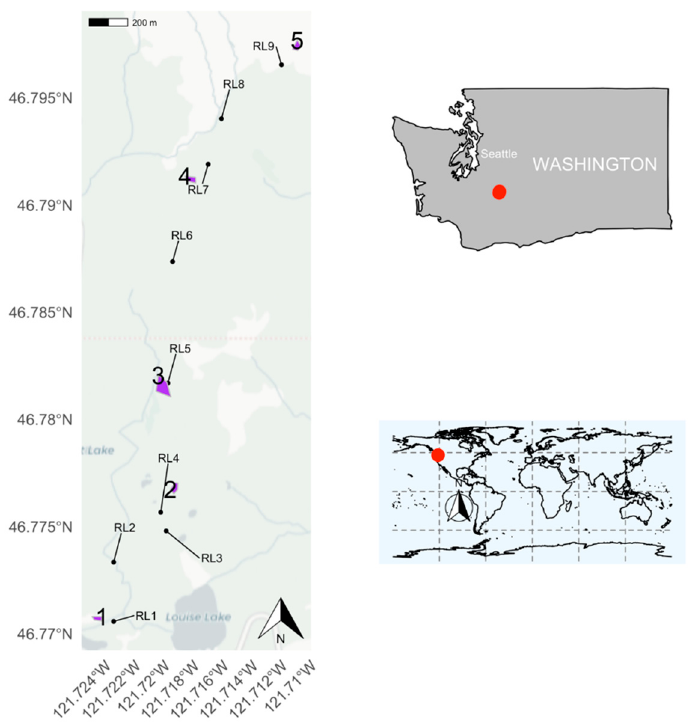
Figure 1. Meadow study sites at Mt. Rainier National Park; five sub-alpine meadows colored in purple are approximately 100 m apart in elevation and cover an elevational gradient from 1490 m to 1900 m. Polygons are the sites from the study Theobald et al. (2017), and the dots annotated with RL1-9 are plots from MeadoWatch.